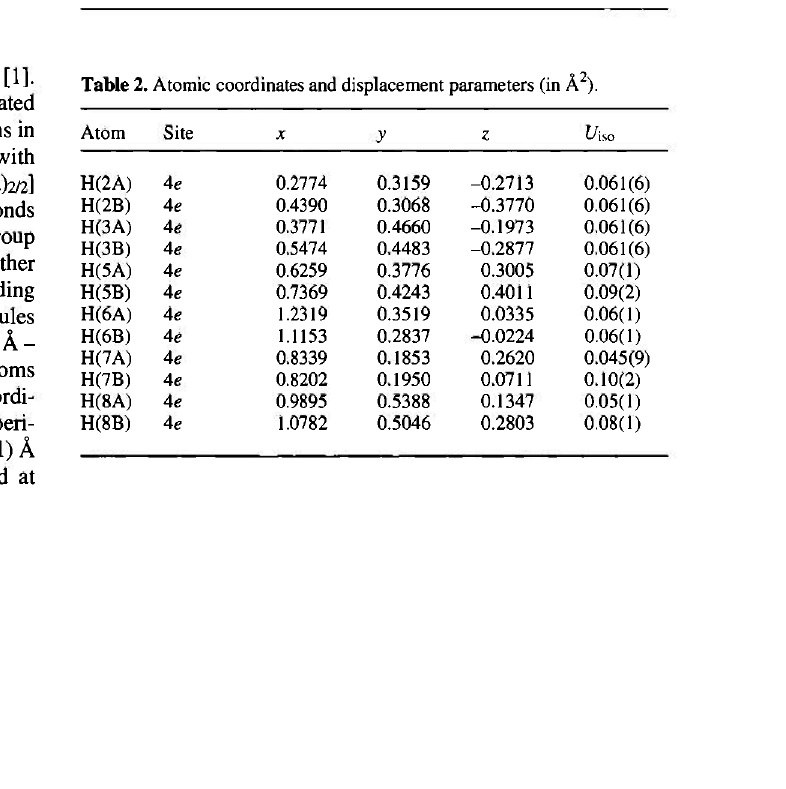
Table 1. Data collection and handling.